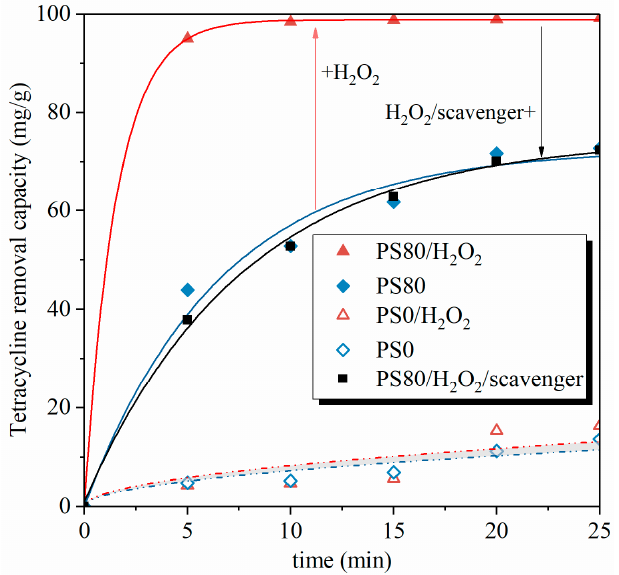
Figure 4. TC removal capacity by PS80 and PS0 with and without H 2 O